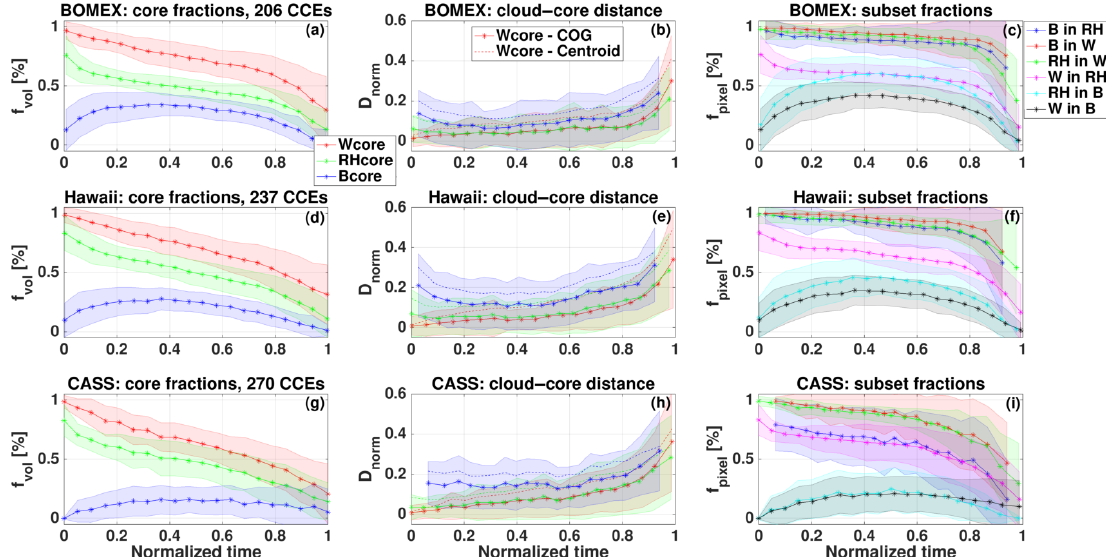
Figure 10. Normalized time series of CCE averaged core fractions for the BOMEX (a, b, c) , Hawaii (d, e, f) , and CASS (g, h, i) simulations. Both core volume fractions ( f vol ; a, d, g ), normalized distances between cloud and core ( D norm ; b, e, h ), and pixel fractions of one core within another ( f pixel ; c, f, i ) are considered. Normalized distance between both COG locations (solid lines) and centroid locations (dotted lines) is shown. Line colors indicated different core types (see legends), while corresponding shaded color regions indicate the standard deviation. Normalized time enables averaging together CCEs with different lifetimes, from formation to dissipation. The number of CCEs averaged together for each simulation is included in the left-column panel